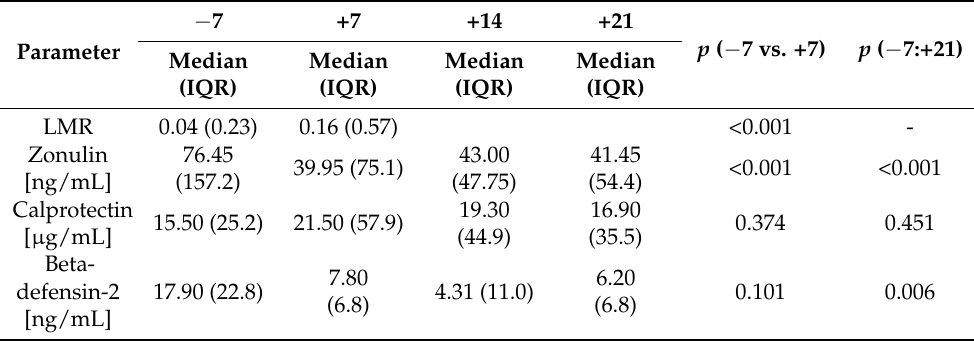
Table 2. Intestinal permeability expressed as LMR and stool biomarkers concentrations before the conditioning and in the post-transplant period. Normal value for LMR is <0.035, for zonulin it is <30 ng/mL, for calprotectin it is <50 µ g/mL, and for beta-defensin-2 it is 8–60 ng/mL. A p -value less than 0.05 is considered to be statistically